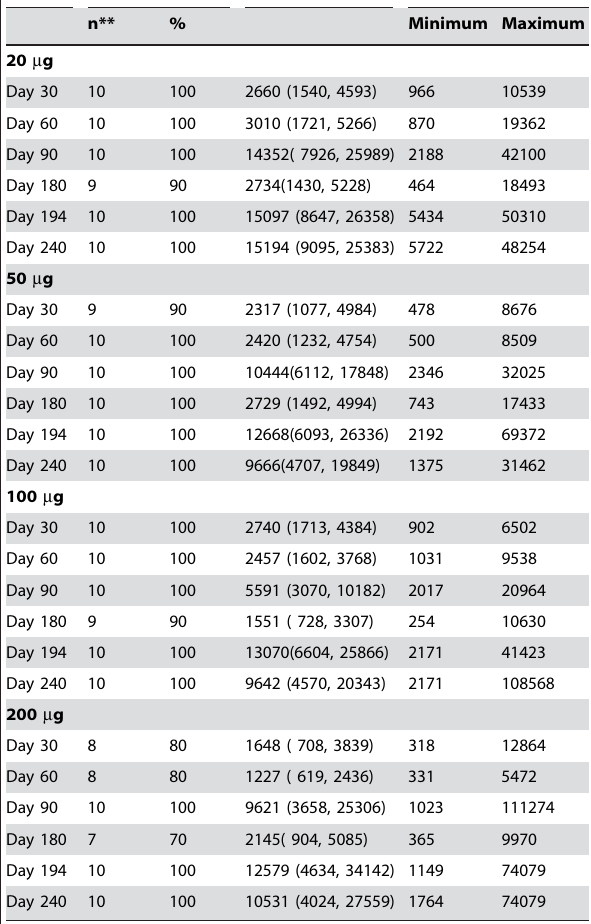
Groups Seroconversion* GMT (95% CI)*** Titers